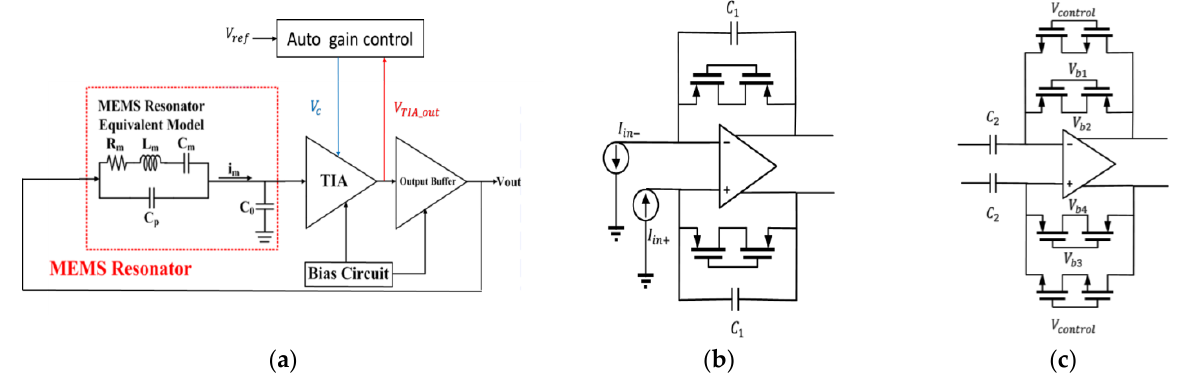
Figure 10. Architecture of ( a ) MEMS oscillator sustaining amplifier, ( b ) integrator, and ( c ) differentiator.